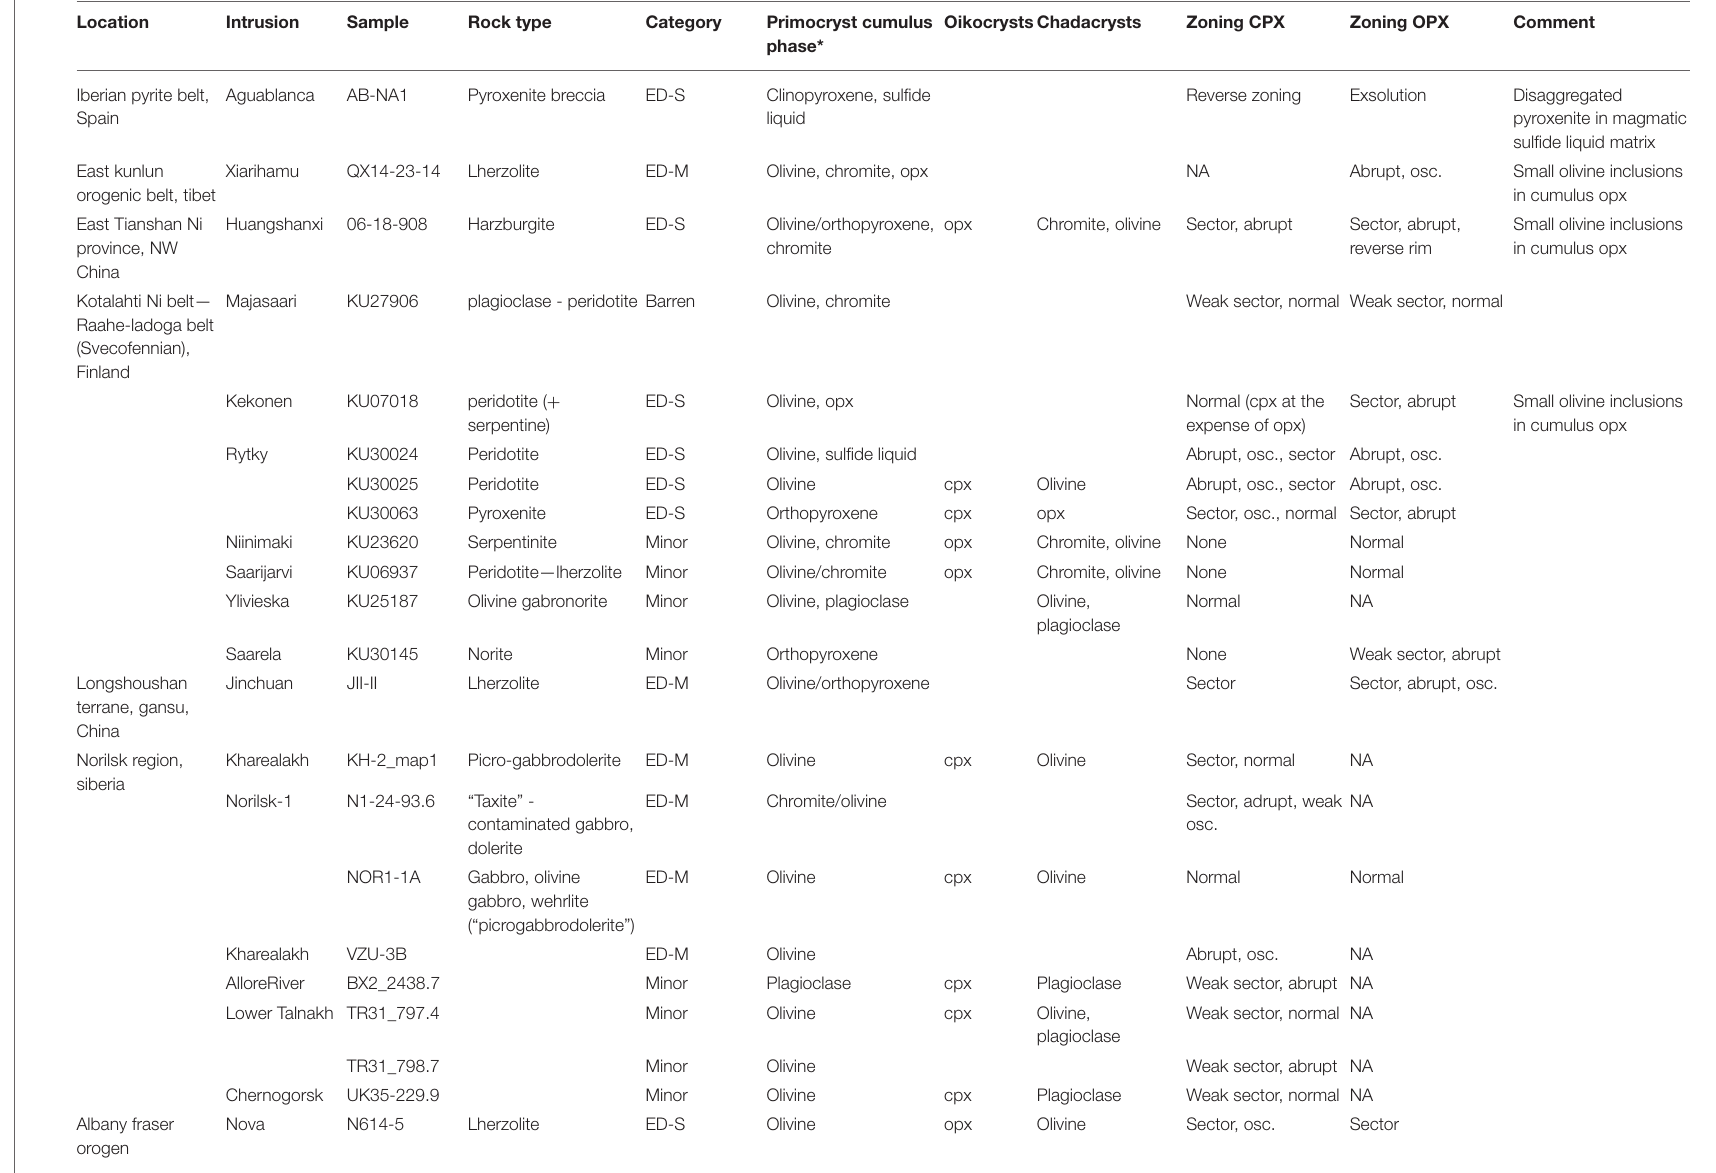
TABLE 1 | Representative samples from each